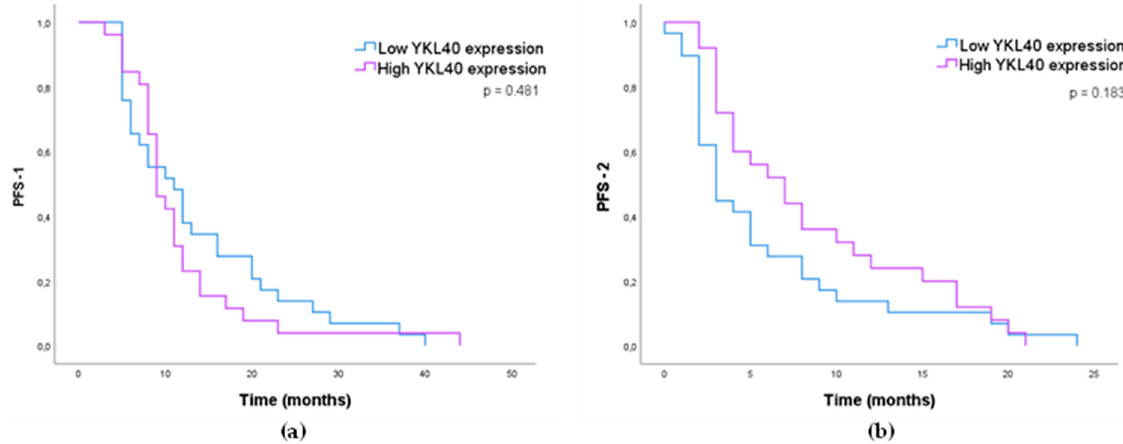
Figure 4. Kaplan–Meier analysis of progression-free survival (in months) after temozolomide treat- ment (PFS-1) ( a ) and bevacizumab treatment (PFS-2) ( b ) according to the expression of